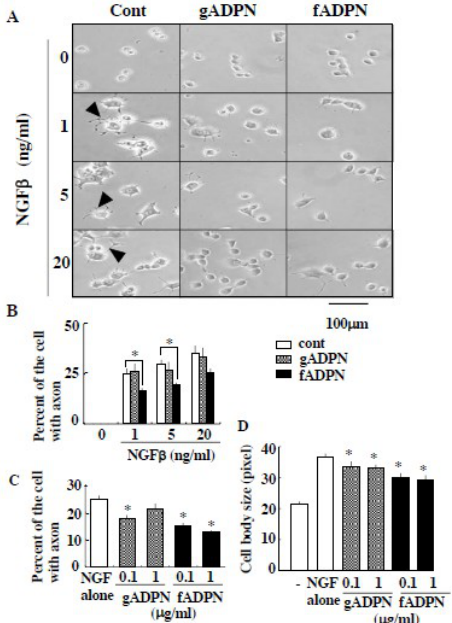
Figure 2. Adiponectin suppressed NGF β -induced neurite outgrowth and cell swelling. ( A , B ) PC12 cells were treated with increasing concentration of NGF β either in the presence or absence of full-length adiponectin (fADPN, 1 µ g/mL) and globular adiponectin (gADPN, 1 µ g/mL). Representative results of the cells (arrowhead: neurite) are shown in A and results (percentage of the cells with axon) from five independent experiments are summarized in B. ( C , D ) PC12 cells were treated with NGF β (1 ng/mL) either in the presence or absence of full length adiponectin and globular adiponectin (0.1 and 1 g/mL). The ratio of the cell with axon ( C ) and the changes in cell body size ( D ) are determined and summarized from three independent experiments. * indicates the statistically significant difference ( p < 0.05) from NGF β treatment alone